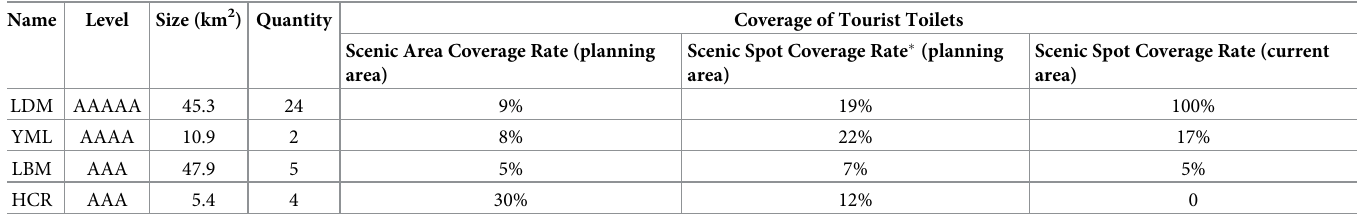
Table 1. Service data regarding tourist toilets in key scenic areas.